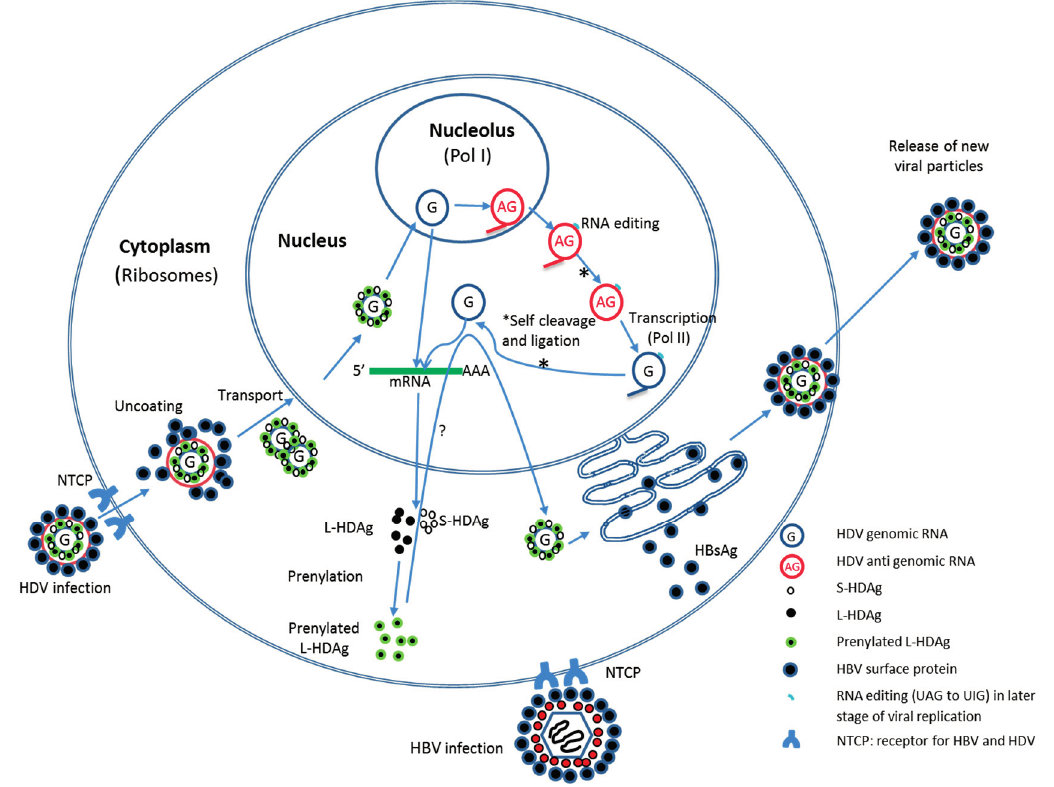
Figure 1. Model of the hepatitis delta virus (HDV) life